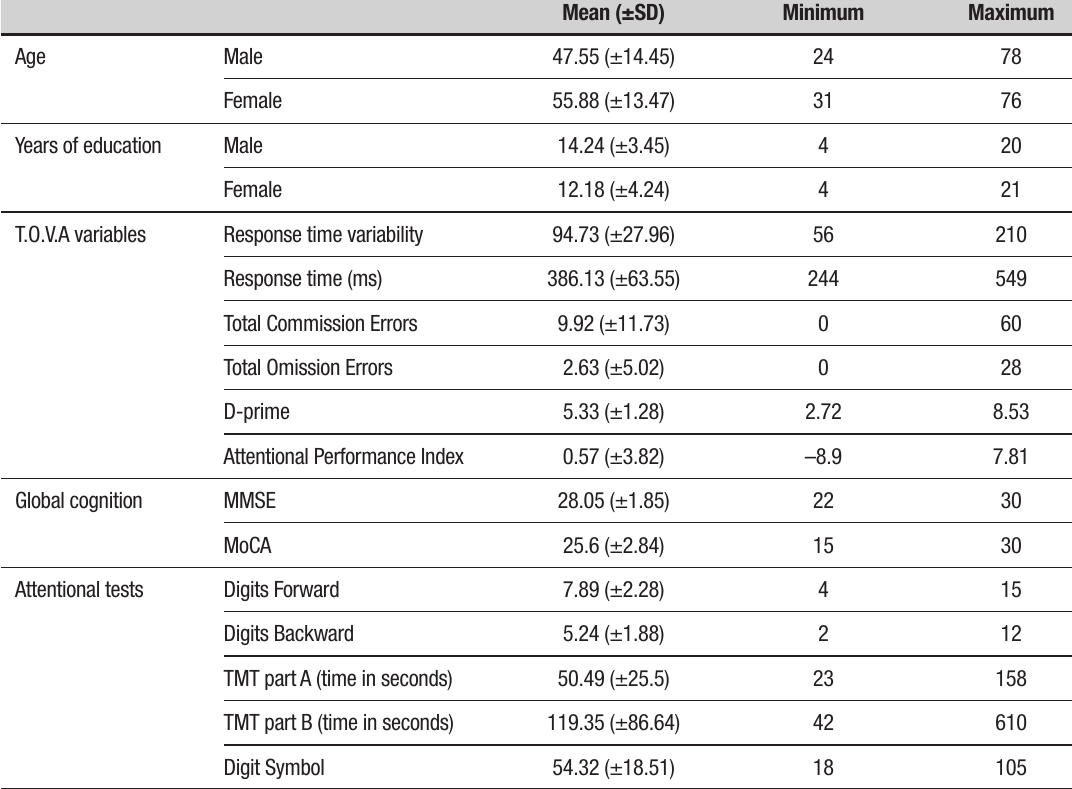
Table 1. Demographic data, T.O.V.A variables and other cognitive tests for the total sample (n=63), presenting means and standard devia- tions with value